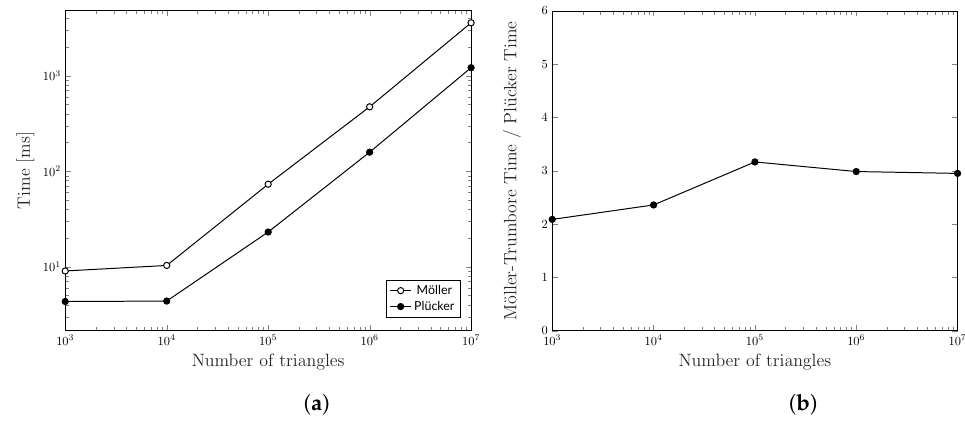
Figure 14. Computation time comparison for intersecting an increasing number of triangles with 1000 rays using Möller-Trumbore and Plücker-based algorithms. ( a ) Computation time, ( b ) Ratio between the computation times of the two